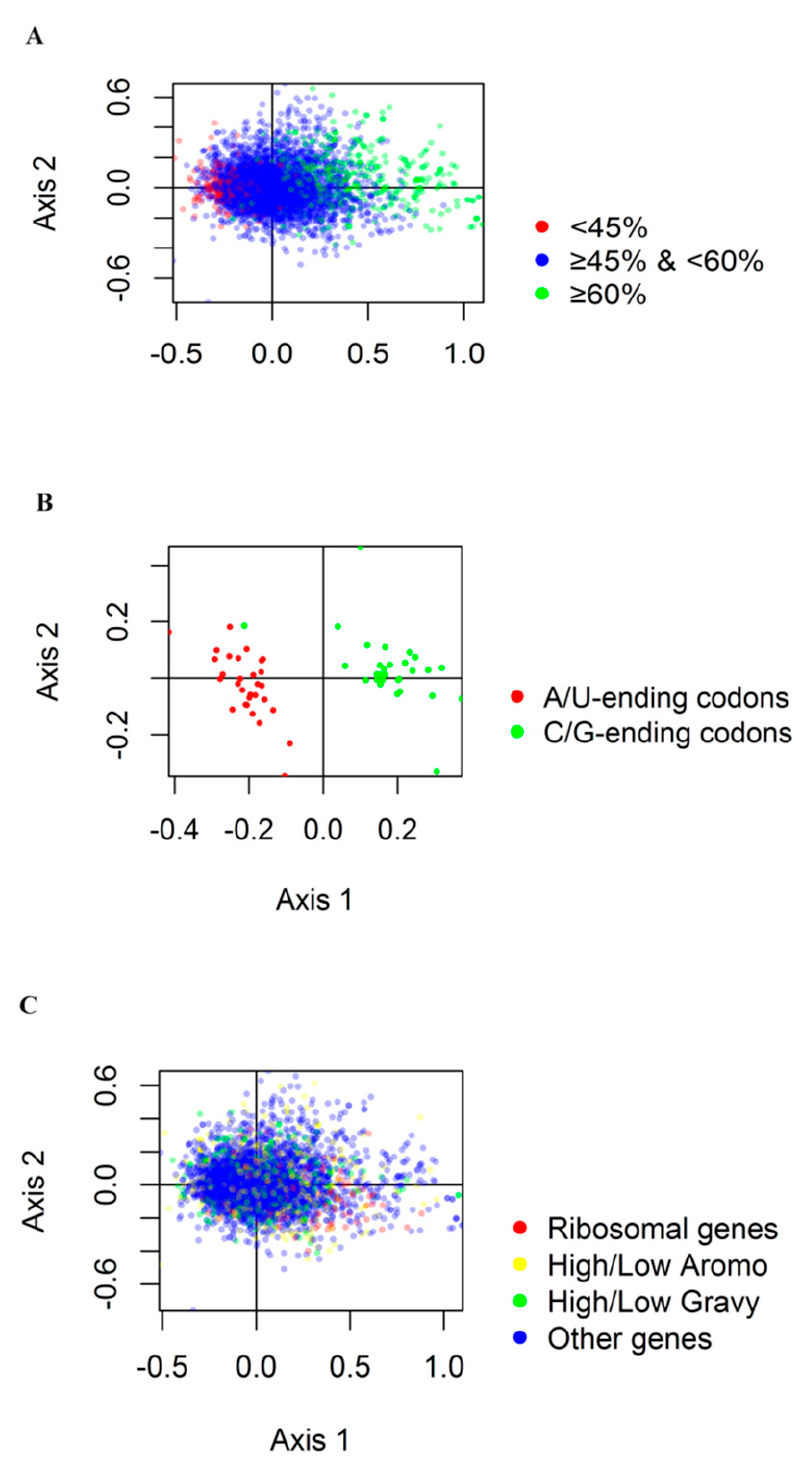
Figure 5. Correspondence analysis of RSCU for G. duodenalis genes. ( A ). The first two axes show the distribution of G. duodenalis genes. Green dots represent G + C content ≥ 60%; Blue dots represent G + C content ≥ 45%, but less than 60%; Red dots represent G + C content ≤ 45%. ( B ). Panel A shows the distribution of codons on the same two axes. Red dots indicate A and T ending codons, and green dots indicate G and C ending codons. ( C ). Red dots represent ribosomal genes, yellow dots represent genes with an Aromo value ≥ 0.15, green dots represent genes with a Gravy value higher than 5, and blue dots represent other